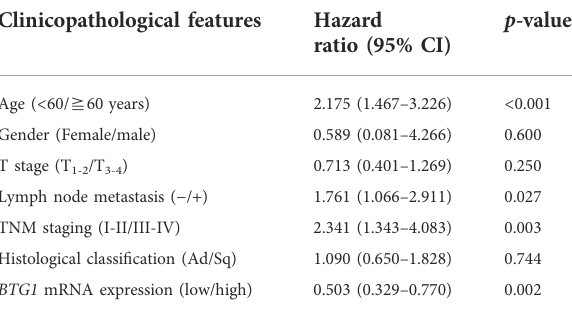
TABLE 2Multivariate analysisofhazard factors of theprognosisof the patients with lung cancer. Clinicopathological